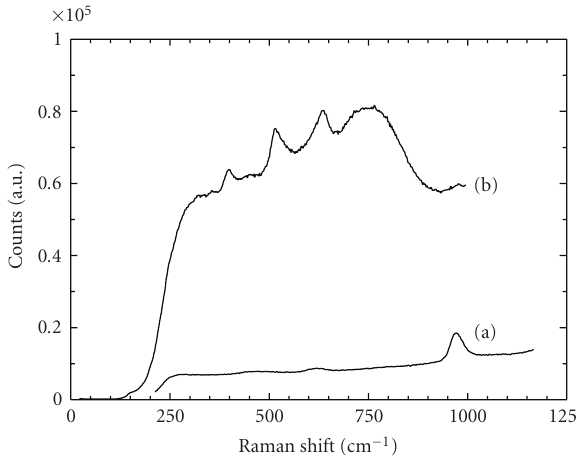
Figure 2: (a) Raman spectra for silver and (b) TiO 2 over silver film.